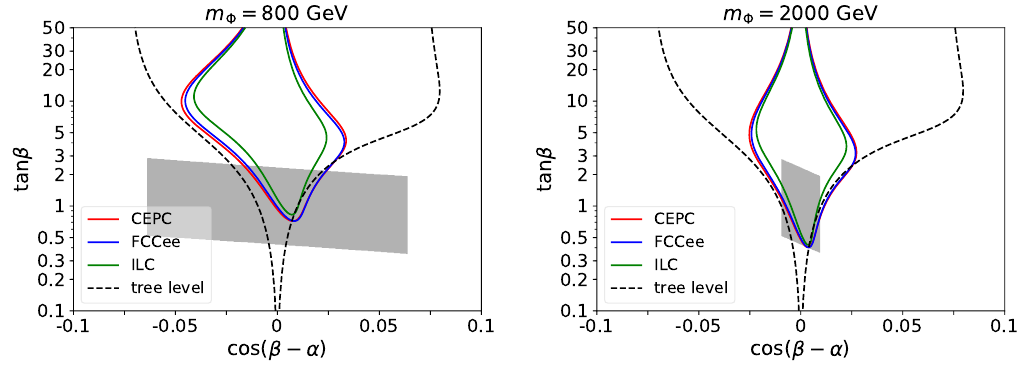
Figure 13 . Allowed region from two-parameter (cid:12)tting results at 95% C.L. in the cos( (cid:12) plane with CEPC (red), Fcc-ee (blue) and ILC (green) precision. The black dashed line indicates the CEPC tree-level only results as a comparison. p (cid:21)v 2 is set to be 300 GeV, with m (cid:8) = 800 GeV (left panel), and 2000 GeV (right panel). The grey shadow indicates the survival region of theoretical constraint.